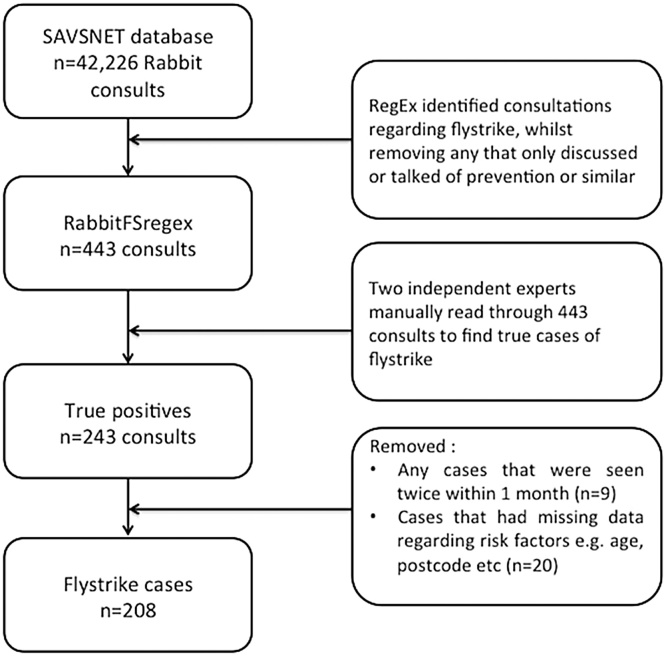
Inclusion and exclusion criteria outlining the process of extracting the true consultations and episodes of blowfly strike from the SAVSNET database.